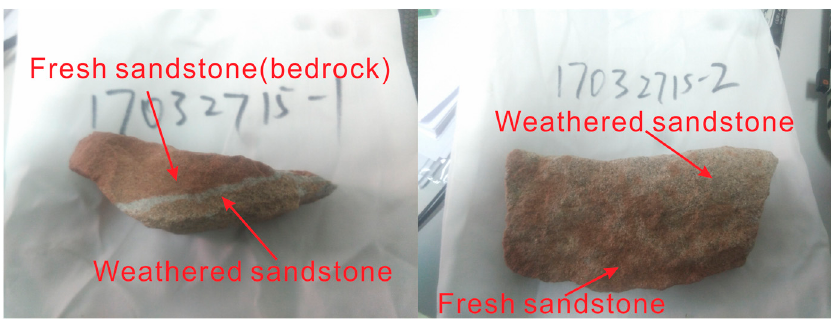
Figure 2. Typical photos show fresh (purplish-red) and weathered (discolored or white)